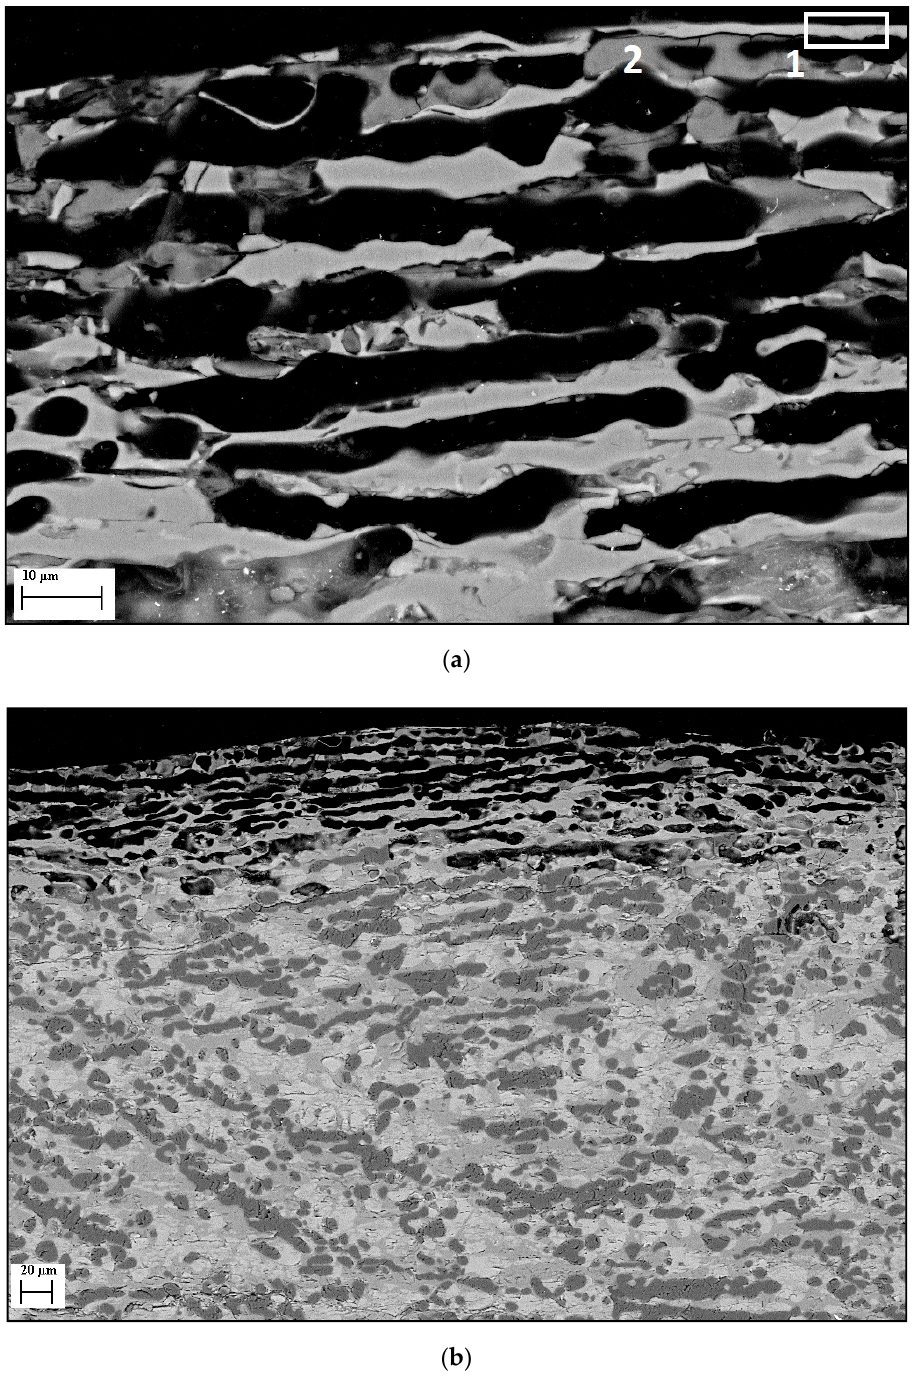
Figure 6. SEM micrographs of a directionally solidified rod grown at 50 mm/h after soaking in the simulated body fluid (SBF) solution for 28 days: longitudinal cross section ( a ) and an extended area of the sample surface in contact with the fluid ( b ).